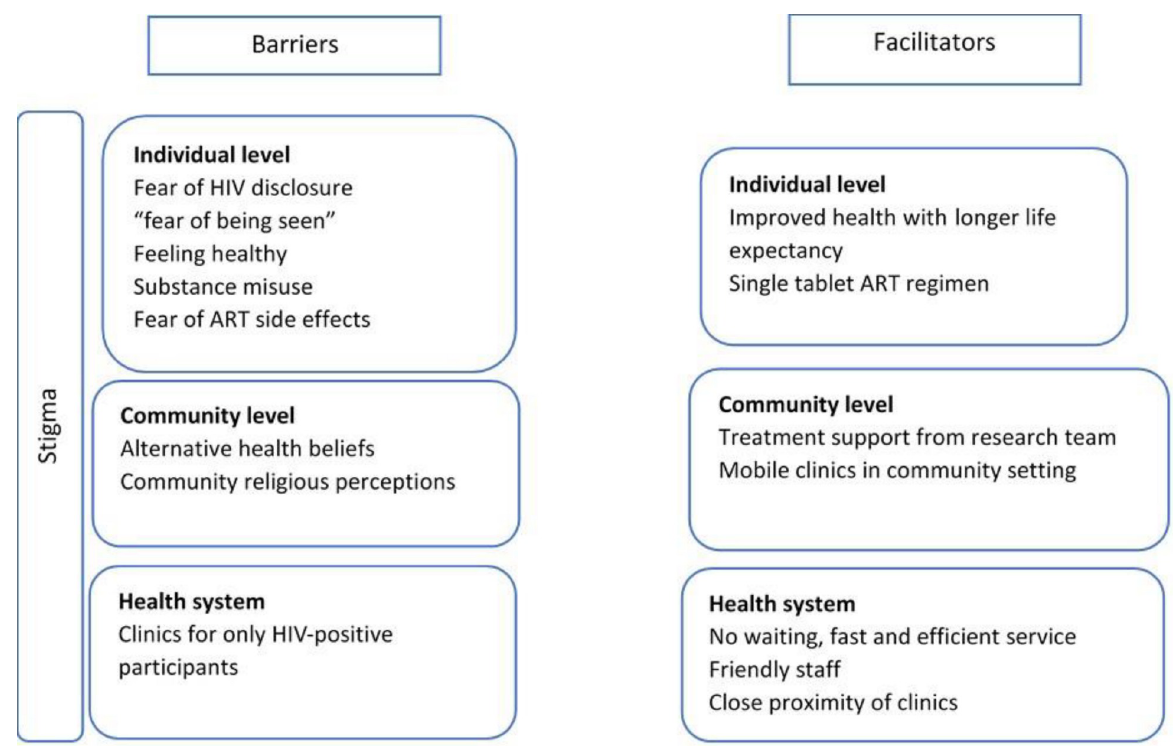
Fig 1. Barriers and facilitators to ART uptake and viral suppression using the socio-ecological model.